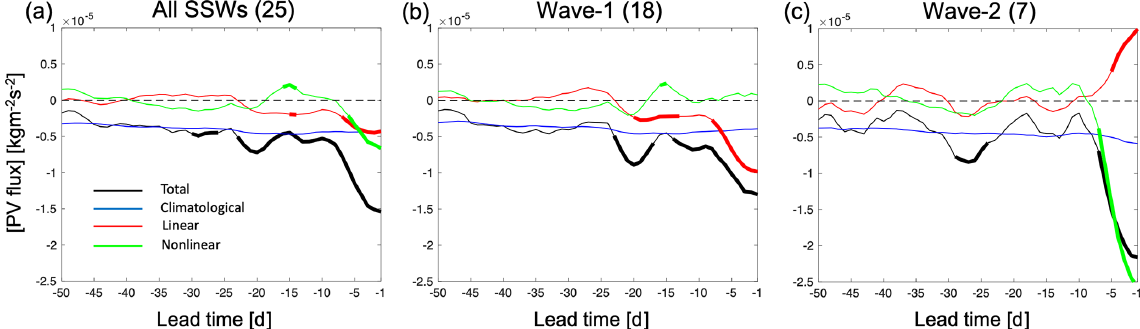
Figure 6. Composites of zonal-mean poleward PV flux averaged north of 45 ◦ N and its decomposition in Eq. (11) as a function of lead time before SSWs: (a) all SSW events, (b) wave-1 events, and (c) wave-2 events in ERA-Interim. A 5d running mean is applied to all lines. Bold lines indicate the values that are outside the percentile range 2.5 to 97.5 of normal winter day values from bootstrapping as described in the text. Panels (a–c) all share the same color legend as (a)